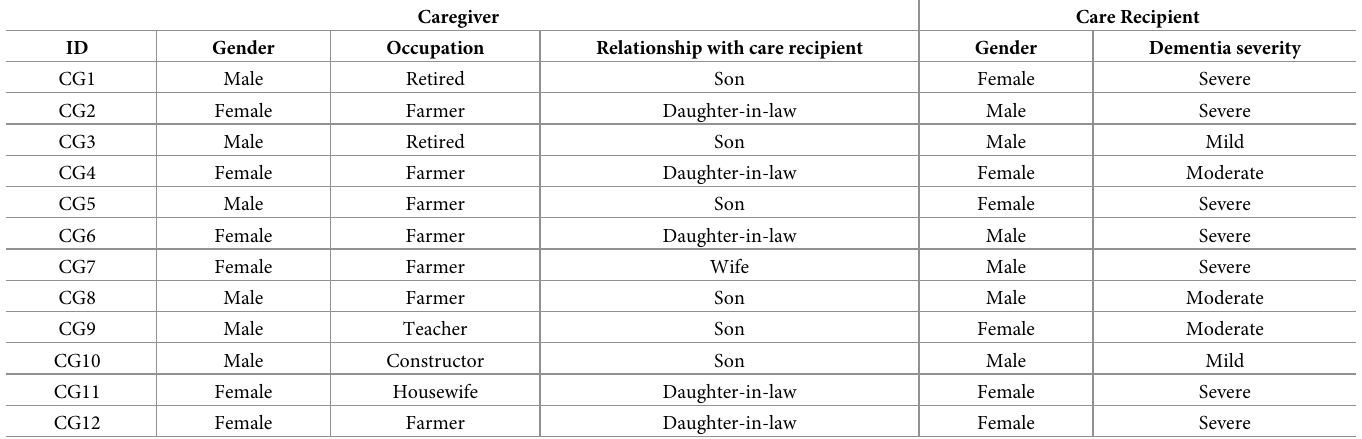
Table 1. Family caregiver and care recipient characteristics (N = 12).